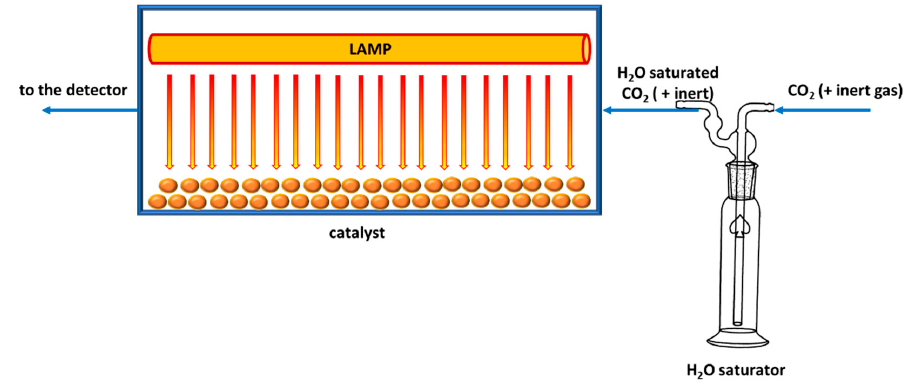
Figure 4. Example of a photoreactor for gas ‐ solid CO 2 photoreduction where a water saturator is employed.